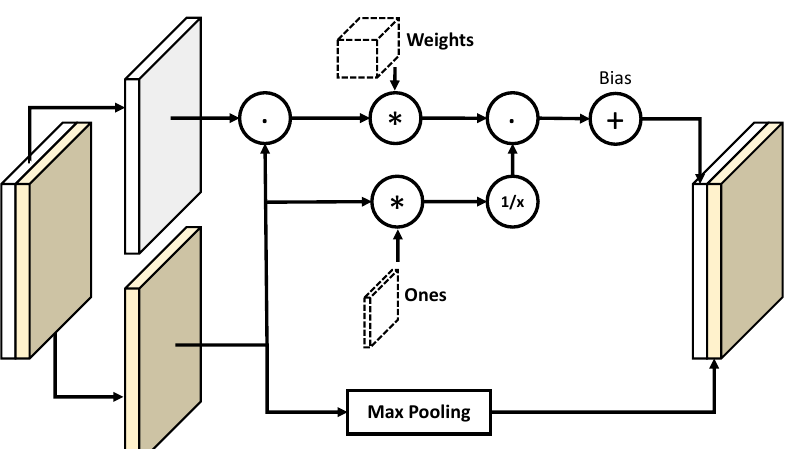
Figure 5. The sparse convolution operation takes an input tensor composed by sparse data (in white) and the associated validity mask (in yellow). Data are convolved and then normalized to account only the valid points encompassed by the kernel. Mask is dilated by the max pooling operation and finally concatenated to the